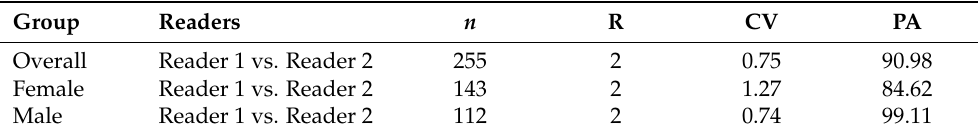
Table 2. Summary statistics for the coefficient of variation (CV), percentage of agreement (%PA) and index of average percentage error (IAPE) to determine the precision of age readings of Dipturus oxyrinchus inhabiting the Northeastern Mediterranean Sea.